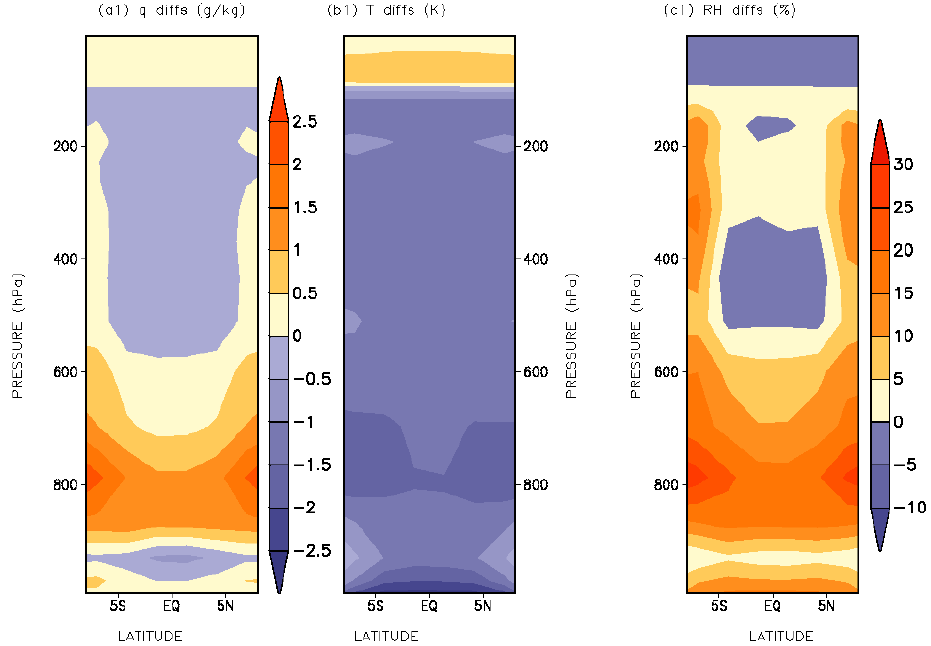
Fig. 8. Vertical profile of the difference between the zonally averaged (0 to 360), time mean, quantities between α =0.7 and α =0.0. (a) specific